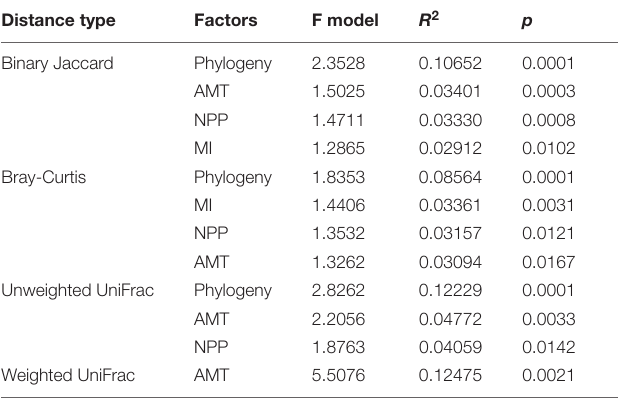
TABLE 2 | The permutation ANOVAs on symbiotic microbiota (permutations = 9,999) for the best models. Distance